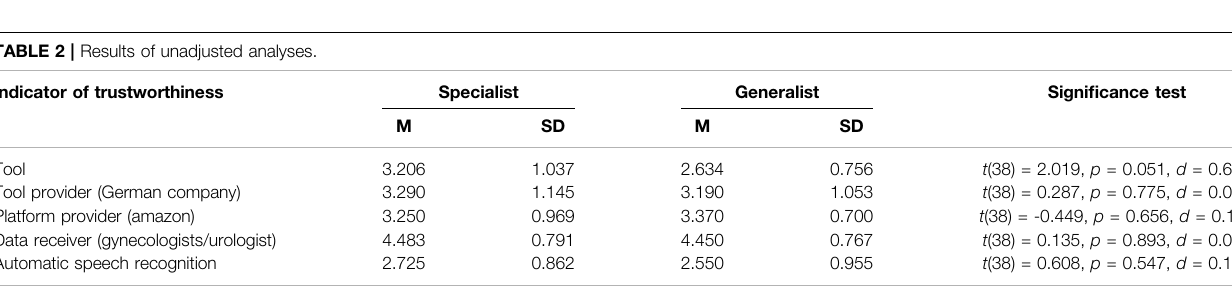
TABLE 2 | Results of unadjusted